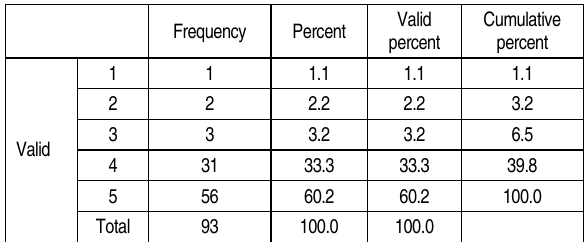
Table 2. Incubator administration is costly and